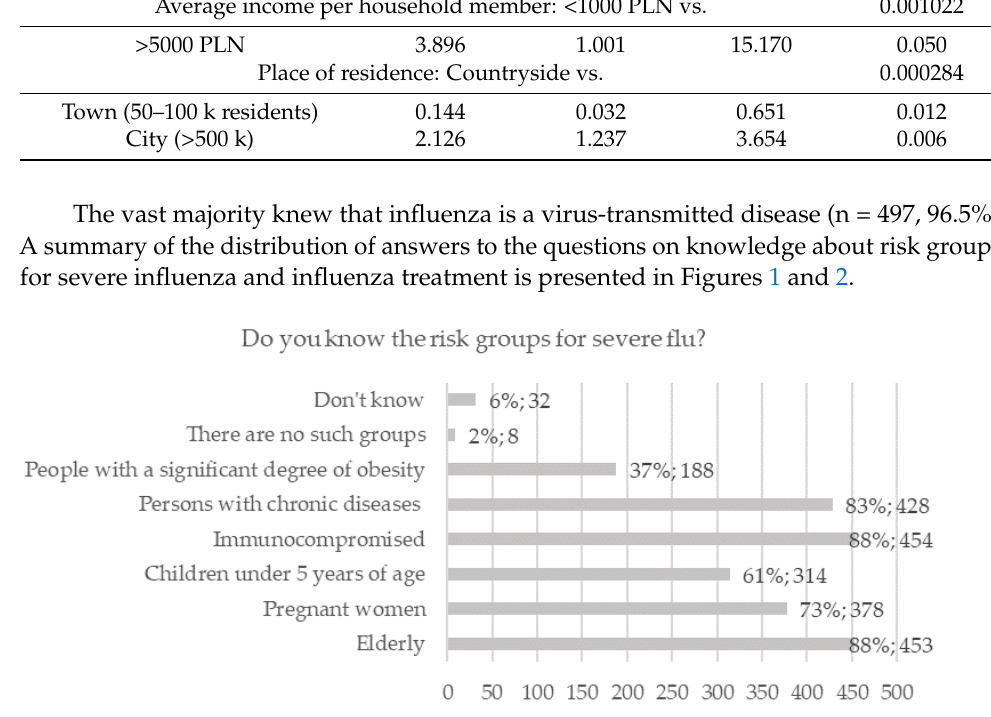
Figure 2. Respondents’ knowledge about influenza treatment. The majority of women had heard about influenza complications that can occur dur- ing pregnancy and in infants. The most commonly indicated complications of influenza in pregnancy were pneumonia (n = 265, 51.5%), premature delivery (n = 237, 46%), and acute respiratory failure (n = 233, 45.2%). Among the post-influenza complications in new- borns, pneumonia (n = 243, 47.2%), respiratory failure (n = 215, 41.7%), and myocarditis (n = 197, 38.3%) were the most frequently chosen. A total of 141 (27.4%) participants had not heard of any complications of influenza in pregnancy and 195 (37.9%) had not heard of any complications of influenza in infants (Tables 7 and 8). Table 7. Participants’ knowledge about the influenza complications in pregnancy . Complications (n = 515)